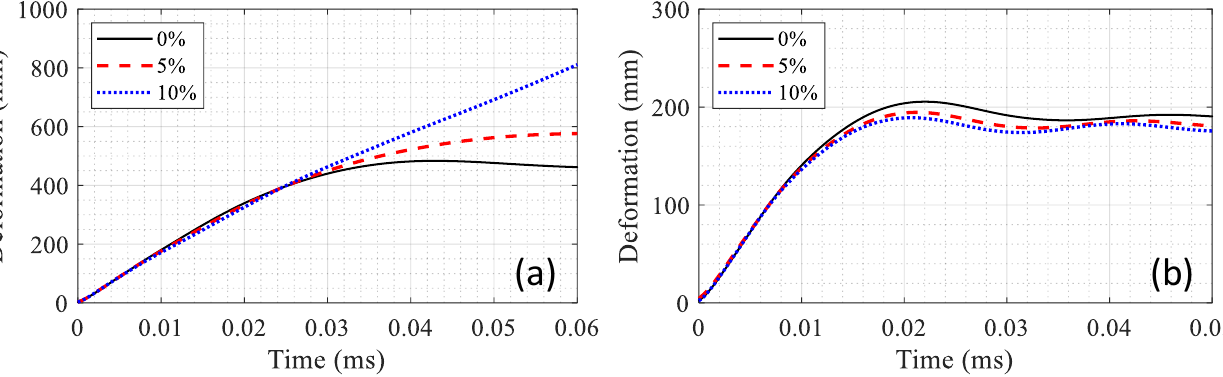
Figure 20. Effect of axial load (percent of maximum axial capacity) on lateral deformation of ( a ) RC and ( b ) composite columns.